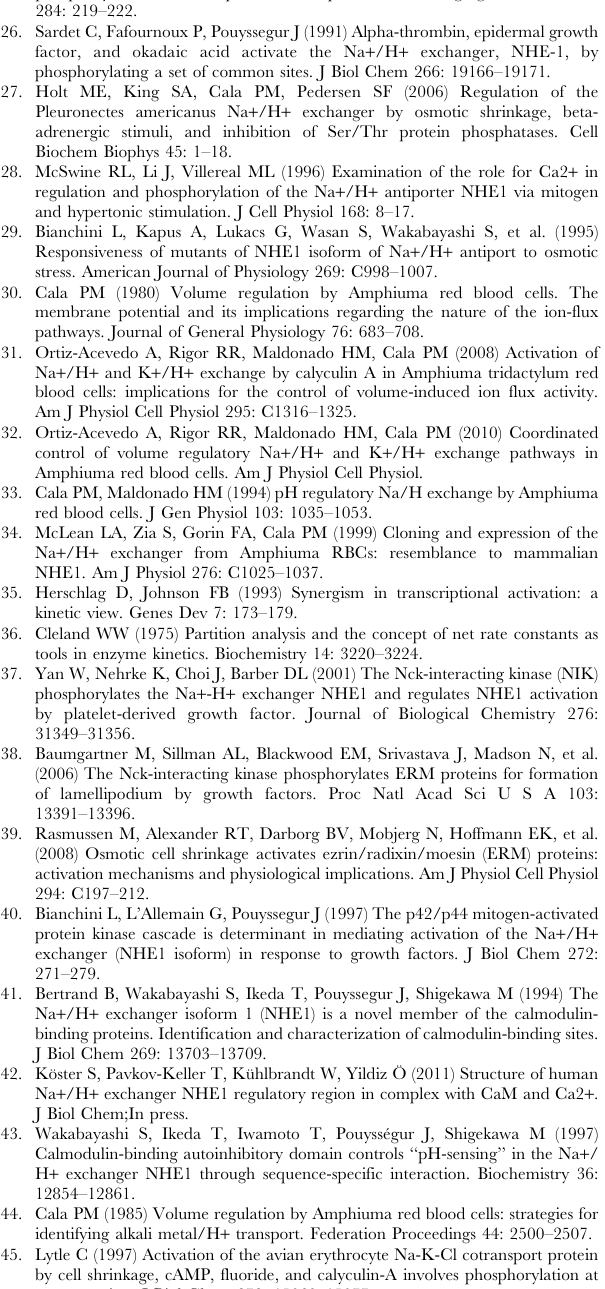
Table S1 A summary of LC-MS/MS data generated from analysis of atNHE1. This complete list of NHE1 phosphorylated peptides identified by LC-MS/MS includes other post-translational modifications, as well as probability of identifi- cation, X!Tandem values, mass:charge (m/z), mass, charge and mass confidence (delta PPM) information.